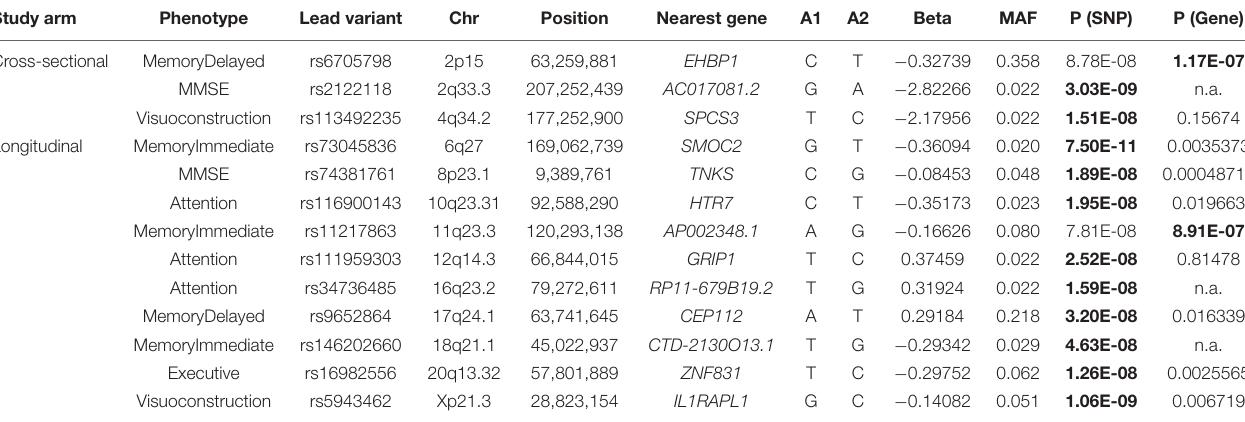
TABLE 2 | Genome-wide significant associations observed in GWAS of cognitive phenotypes.